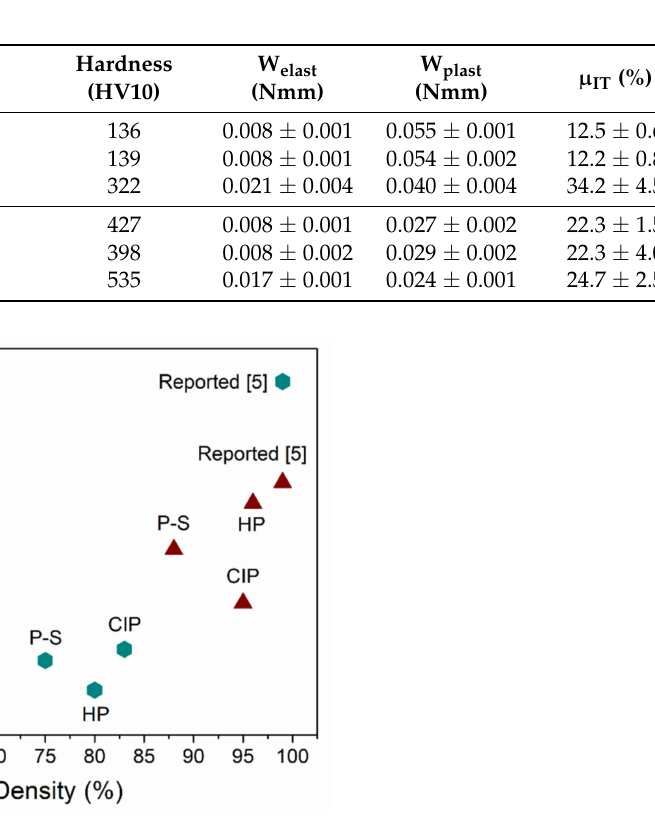
Figure 8. The E modulus of uniaxially (P-S), cold isostatic pressed and sintering (CIP) and hot- pressed (HP) Ti 3 SiC 2 and Cr 2 AlC MAX phases compared with the reported values from Barsoum, M.